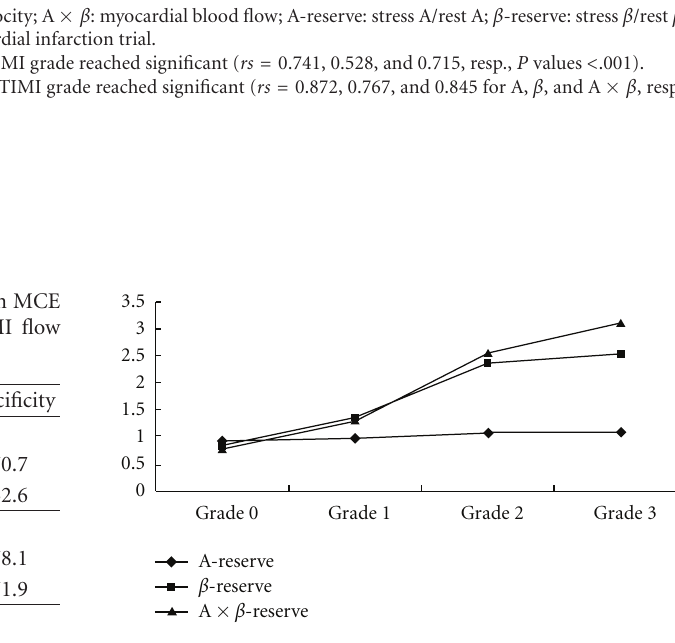
Figure 2: Trend of intergroup reserve of MEC parameters among groups of each coronary artery TIMI grade. Table 6: Reproducibility of quantitative assessment of myocardial perfusion